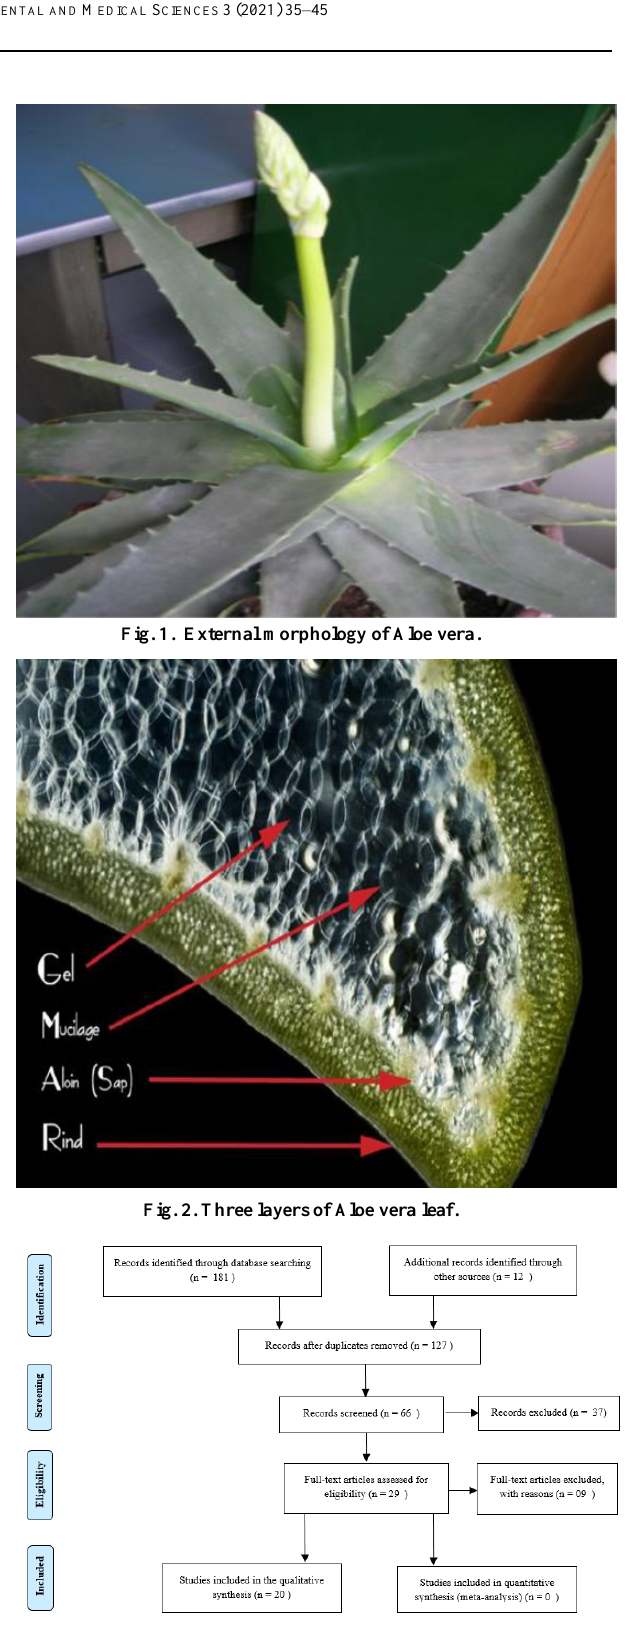
Fig 3. PRISMA Flow